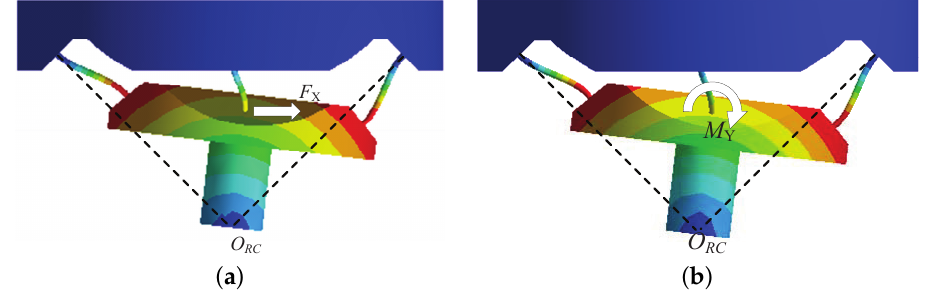
Figure 7. Finite element analysis (FEA) results of the RCC mechanism in different loading cases of ( a ) Direction fixed force F X and ( b ) Pure Moment M Y .